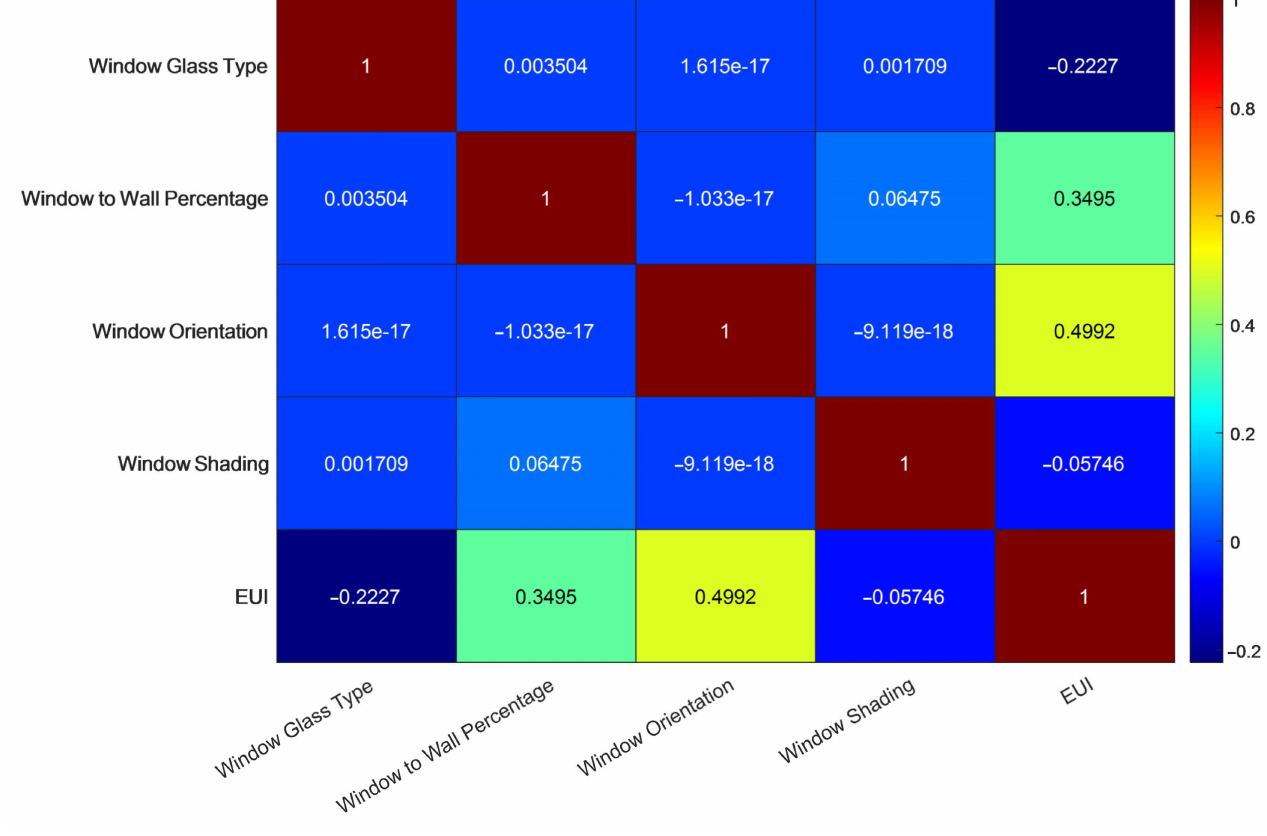
Figure 6. Correlation matrix for WWR internal influencing elements.